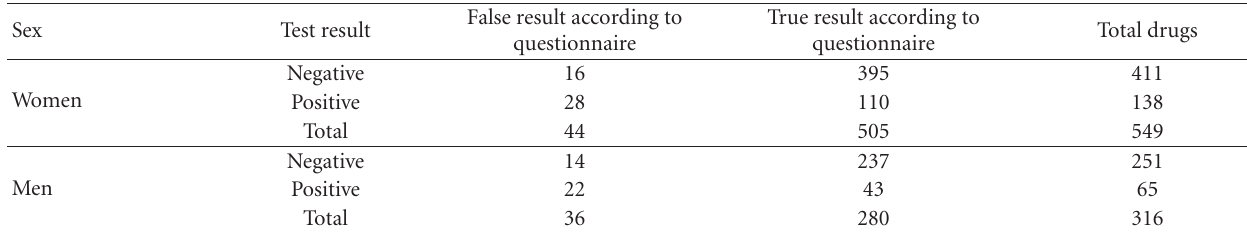
Table 3: Correlation between patient’s sex and IFN-gamma release results for all medications.